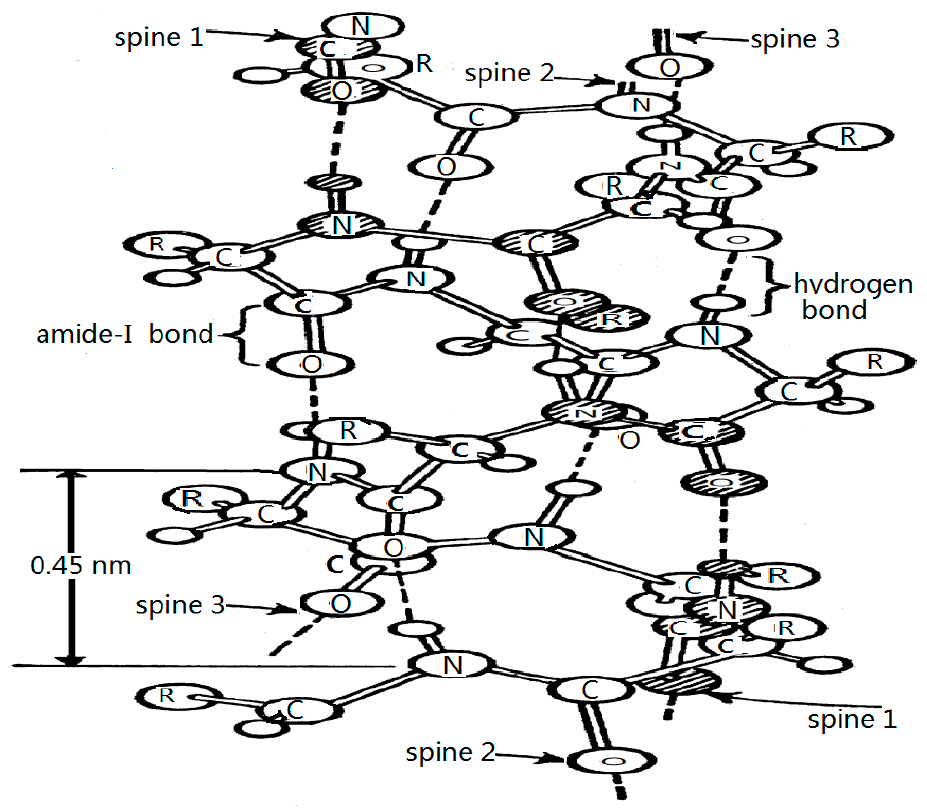
Figure 1. The molecular structure of an α -helical protein molecule.